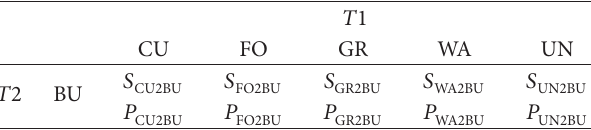
Table 1: Land-use conversion matrix for non-built-up area to built- up